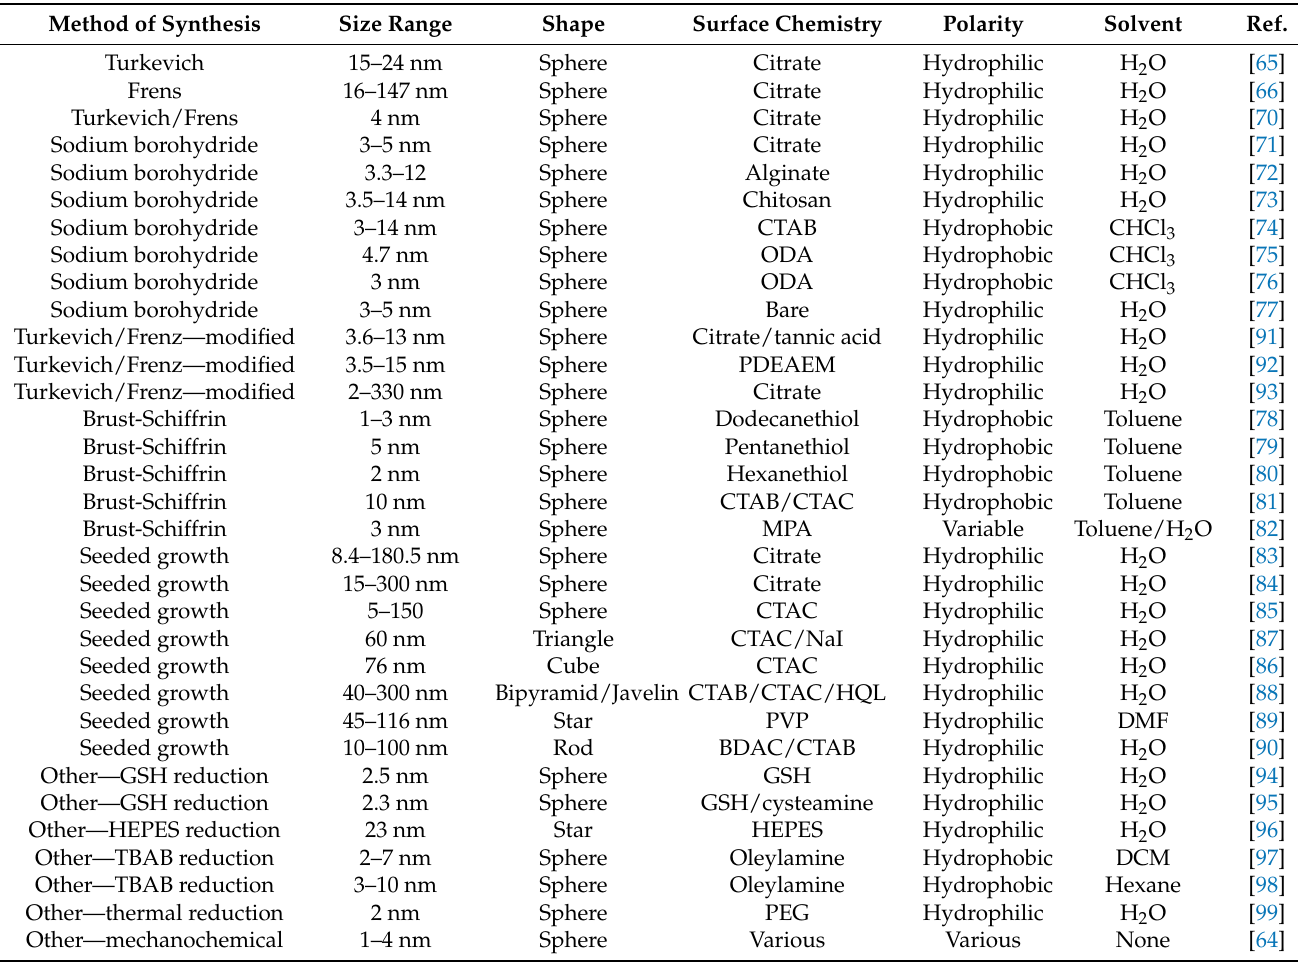
Table 2. Methods of AuNP Synthesis. Focusing mainly on ultrasmall spheres, with several prominent examples of methods for synthesizing larger or non-spherical